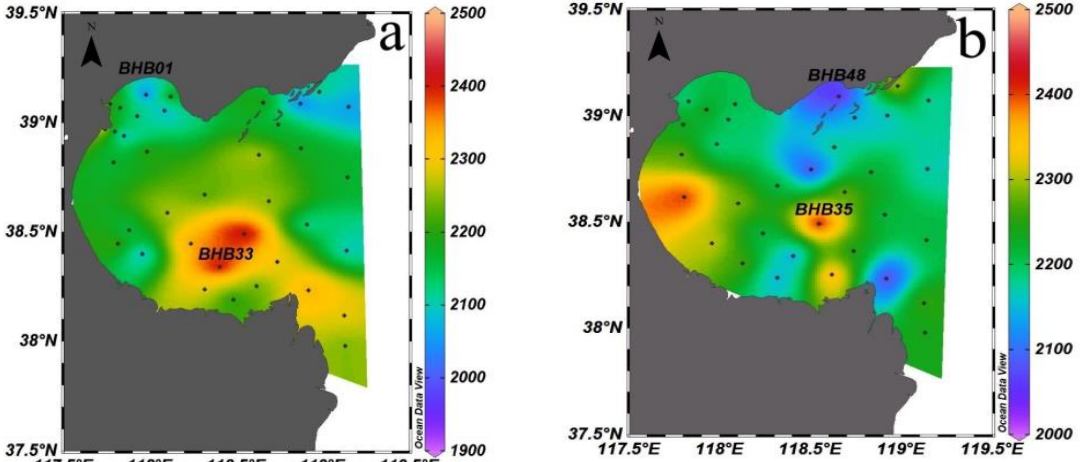
Figure 5. Horizontal distributions of DIC ( µ mol/kg) in the surface seawater ( a ) and bottom seawater ( b ) in Bohai Bay in summer 2020. The scale is 1:3,700,000. This image was created with ODV software, version 5.3.0 (Alfred Wegener Institute, Bremerhaven,